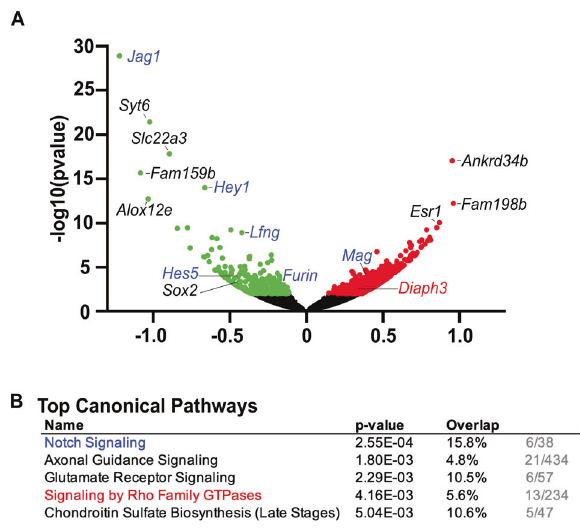
Fig. 6 Transcriptional analyses indicate a potential defect in stereocilia formation. A Volcano plot from RNA-seq analysis of P6 Sox2 CreER/ + Jag1 fl / fl and Sox2 + / + littermate cochleae ( n = 6 per genotype). A total of 411 genes were signi fi cantly upregulated (red dots) and 137 genes were signi fi cantly downregulated (green dots). Genes in the Notch pathway that show signi fi cant differences are indicated in blue. Diaph3 , a gene in the Rho GTPase family, is shown in red. B Top canonical pathways affected by loss of JAG1 identi fi ed by Ingenuity Pathway Analysis (IPA). Five of the top pathways whose gene members were signi fi cantly different between Sox2 Cre/ + Jag1 fl / fl and Sox2 + / + . Overlap indicated the percentage of genes affected in each pathway (actual numbers are shown in